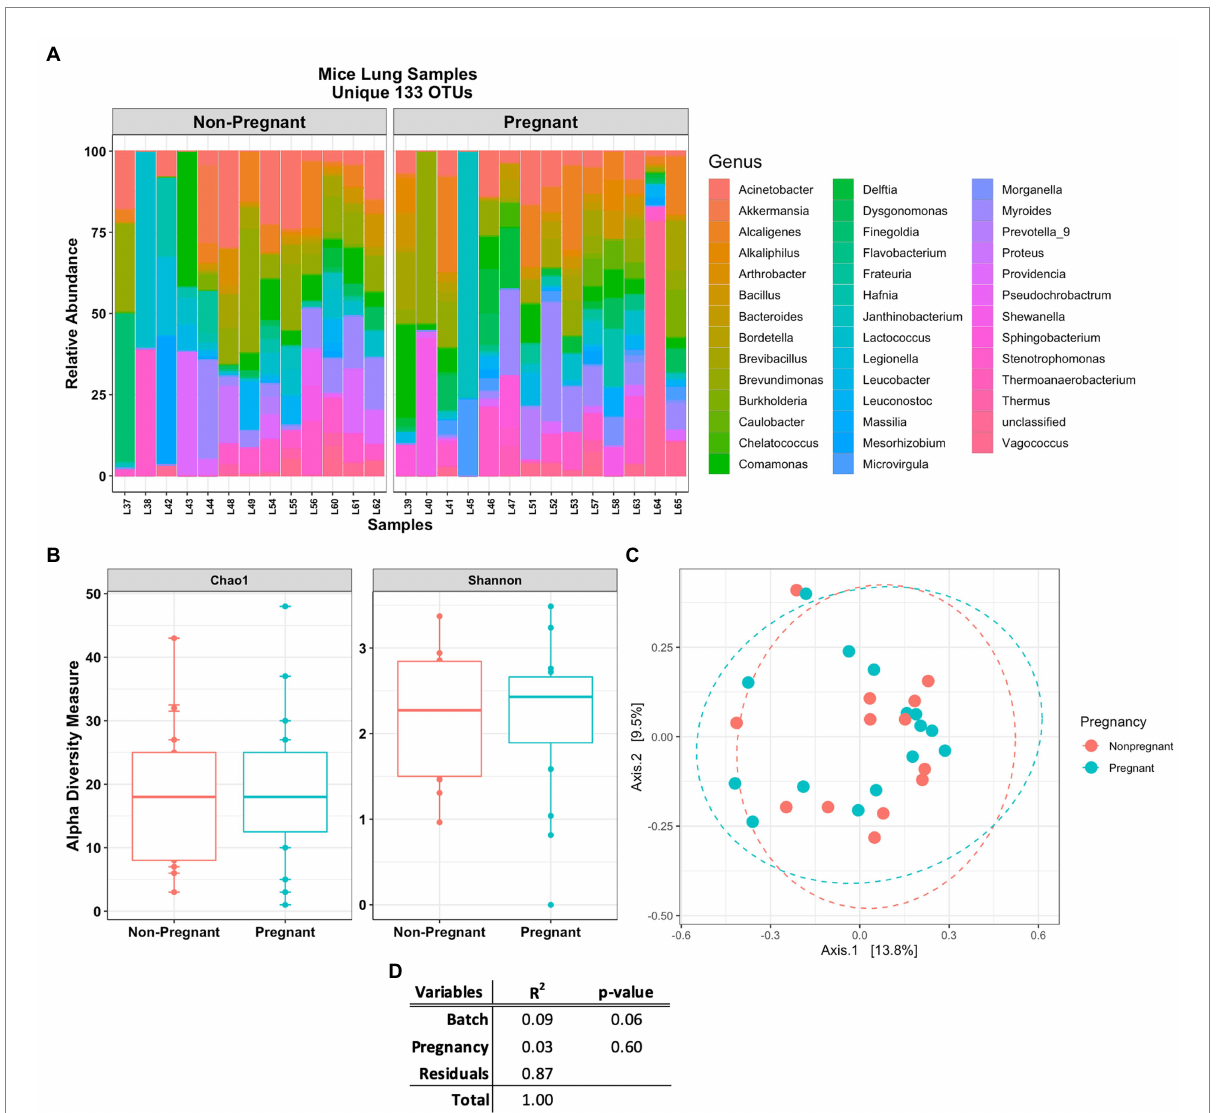
FIGURE 4 Mice lung samples unique 133 OTUs. (A) Abundance plot of pregnant and non-pregnant mice lung samples top 50 unique OTUs. The unique lung microbiome was composed of environmental- and host-associated taxon. (B) Comparing alpha and (C) beta (unweighted Bray-Curtis PCoA) diversity index of the pregnant and non-pregnant groups. (D) Statistical summary of the PERMANOVA test comparing pregnancy and DNA batch extraction variables, no unique microbial signature was observed for the pregnancy variable in the unique lung